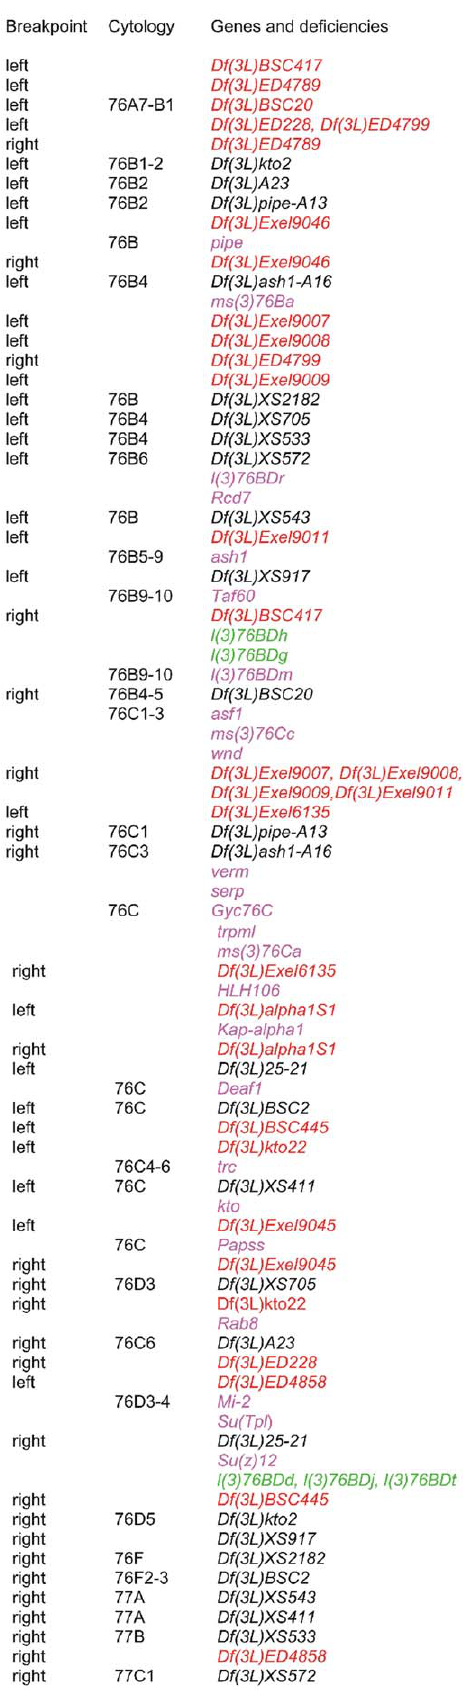
Figure 3. Cytogenetic map showing the deficiencies and genes in polytene chromosome region 76B-D. The cytological locations are only given for deletions or genes mapped on polytene chromo- somes (which do not always correspond to the cytological locations given for the molecular map by the Drosophila Genome Project). Deficiency breakpoints localized on the molecular map are indicated in red and the non-localized breakpoints are indicated in black. Genes are in purple if the transcription unit has been identified, and in green if the transcription unit is not currently known.